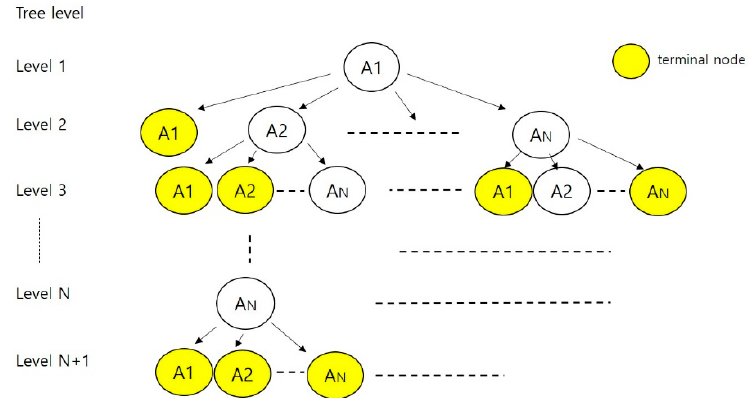
Figure 6. Tree using W method.